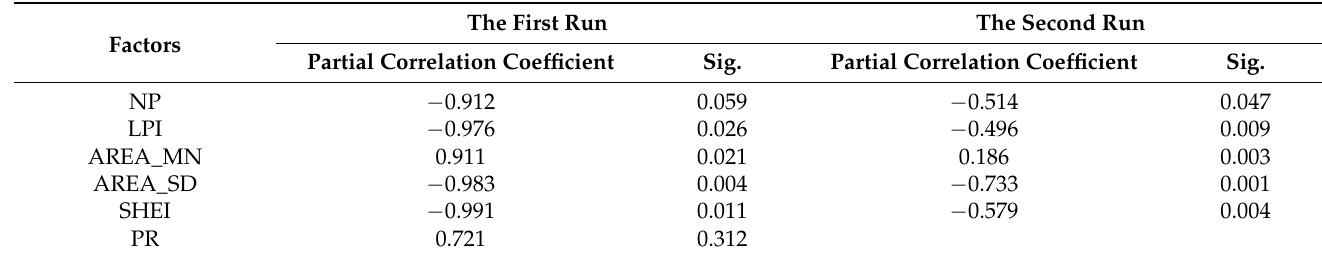
Table 4. Stepwise regression process and partial correlation